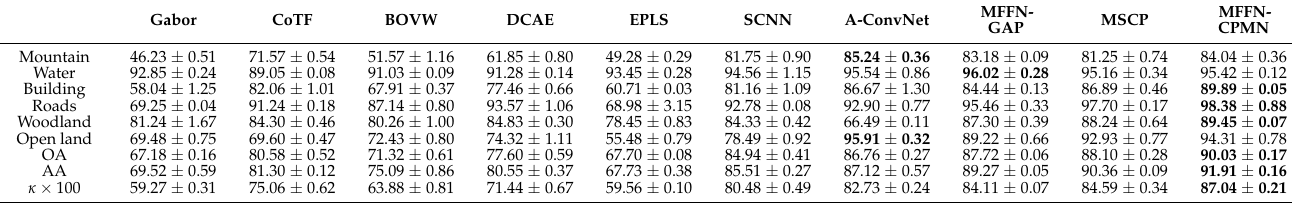
Figure 12. Classification maps of TerraSAR-X image with different methods. ( a ) Ground-truth. ( b ) Gabor. ( c ) CoTF. ( d ) BOVW. ( e ) DCAE. ( f ) EPLS. ( g ) SCNN. ( h ) A-ConvNet. ( i ) MFFN-GAP. ( j ) MSCP. ( k ) MFFN-CPMN. Table 6. Classification performance of Gaofen-3 SAR image with different